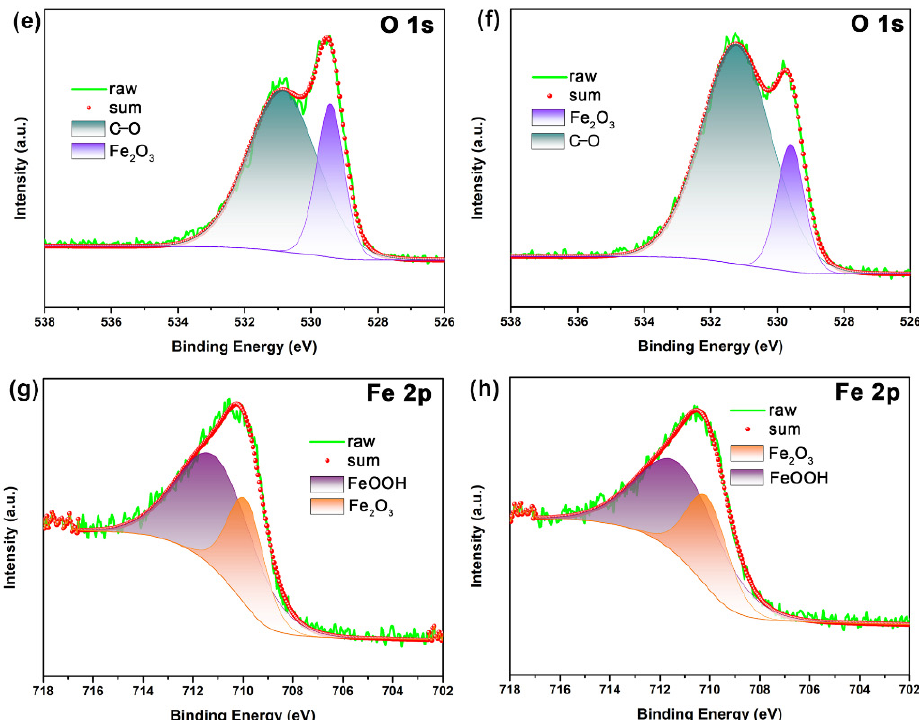
Figure 12. The high-resolution XPS spectra of the steel surface after exposure to 1 M HCl solution and in the presence of 400 ppm NCDs, ( a , b ) N 1s, ( c , d ) C1s, ( e , f ) O 1s and ( g , h ) Fe